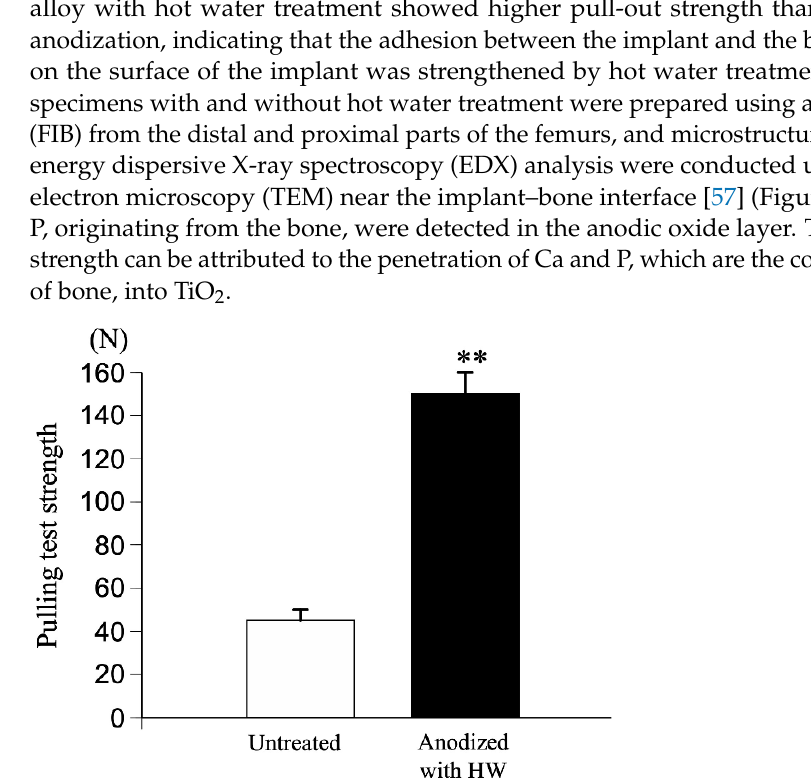
Figure 5. Evaluation of bone-metal interface by SEM image and EDX mapping of the elements with implanted TiNbSn rod . Evaluation of the bone–metal interface was performed by SEM im- aging and EDX mapping of Ti, Nb, O, Ca, and P near the rabbit bone and the implanted TiNbSn rod. SEM: Scanning electron microscopy; EDX: Energy dispersive X-ray spectroscopy. (reprinted from Ref. [57] with permission). According to previous studies on the biocompatibility of anodized TiO 2 , the mecha- nism of its development differs for nanotubes and surface-roughening. Nanotubes have been proposed in terms of both the porous structure and composition of TiO 2 , although a consistent mechanism has not been established yet. However, the latter generally involves the enhancement of osteoblast adsorption by TiO 2 surface roughening, although there are some differences among reports. The mechanism of HAp formation by hot water treat- ment is similar to this approach, and Kokubo et al., proposed an increase in hydroxyl adsorption by hot water treatment and crystallographic coherency between rutile TiO 2 and HAp [54,55]. The results of XPS angle-resolved measurements of anodized TiNbSn alloys prepared in a 1 M acetic acid electrolyte have been reported [57]. After hot water treatment, XPS analysis revealed that the fraction of O 1 s hydroxyl groups decreased, and the oxide fraction increased compared to those before treatment. For niobium (Nb) oxide